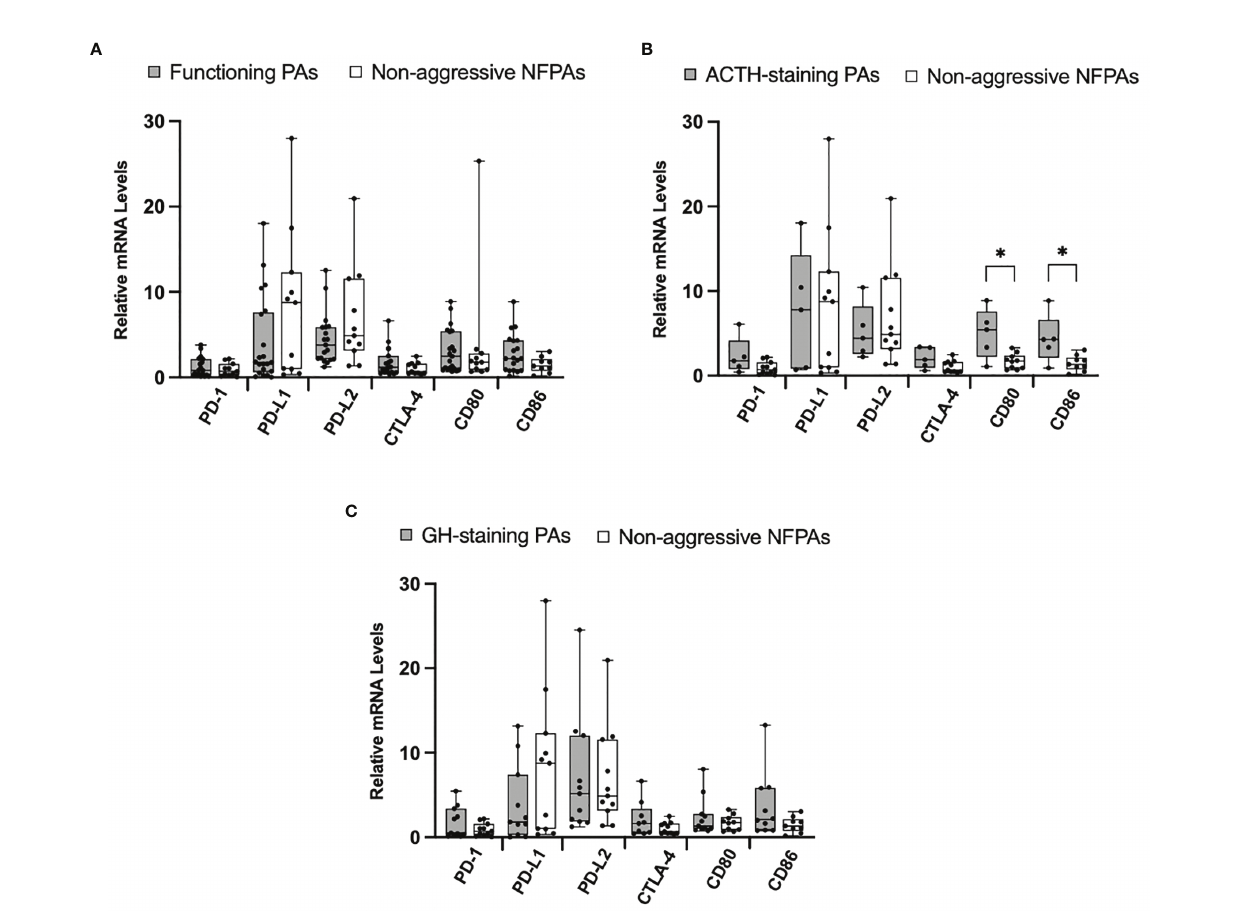
FIGURE 3 | Immune checkpoint molecule mRNA expression in functioning PAs compared to non-functioning PAs. (A) Comparison of relative mRNA levels of immune checkpoint molecules between functioning PAs (gray) and non-functioning non-aggressive PAs (white). (B) Comparison of relative mRNA levels of immune checkpoint molecules between ACTH-staining PAs (gray) compared to non-functioning non-aggressive PAs (white). (C) Comparison of relative mRNA levels of immune checkpoint molecules between GH-staining PAs (gray) compared to non-functioning non-aggressive PAs (white). * p <